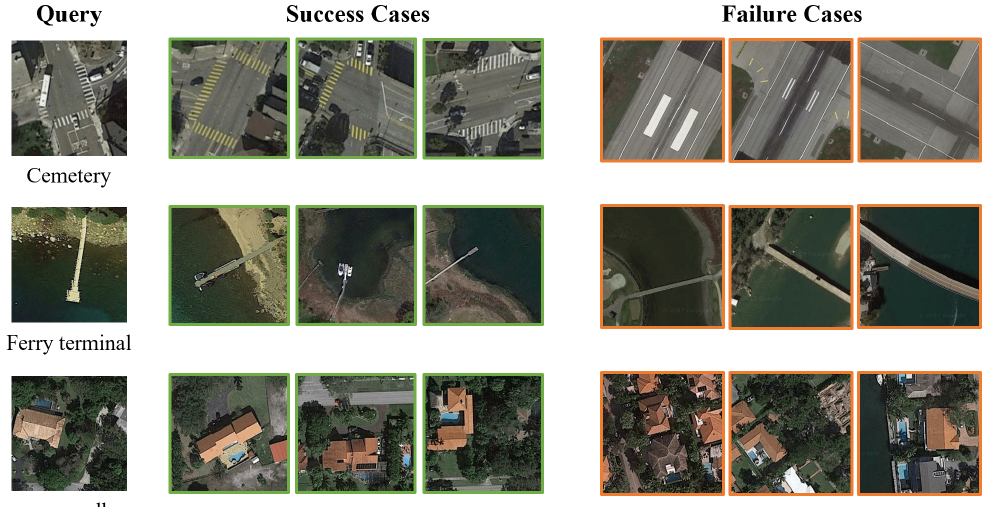
Figure 17. Examples of PatternNet retrieval results. Column 1 is the query sample, columns 2–4 are the success cases of our method, and columns 5–7 are the failure cases.